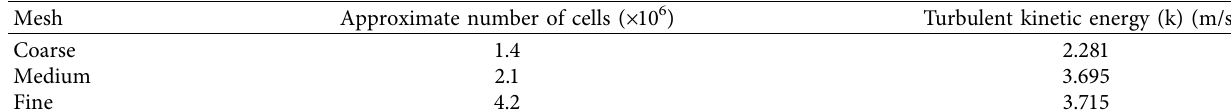
Table 2: Mesh independence